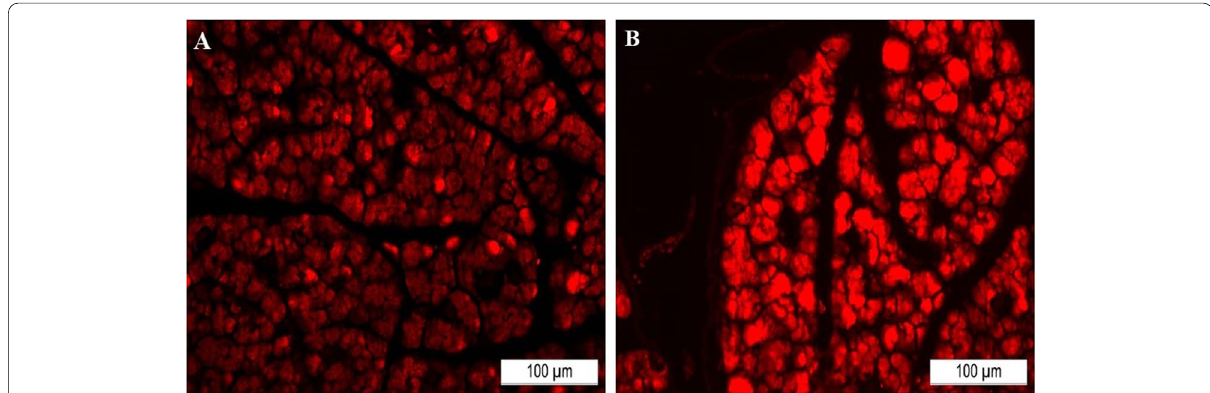
Fig. 7 Homing of systemically administered IPCs in pancreas sections of different treated groups. A IPCs generated from hDPSCS. B IPCs generated from hPDLCSs (scale bar 100μm)